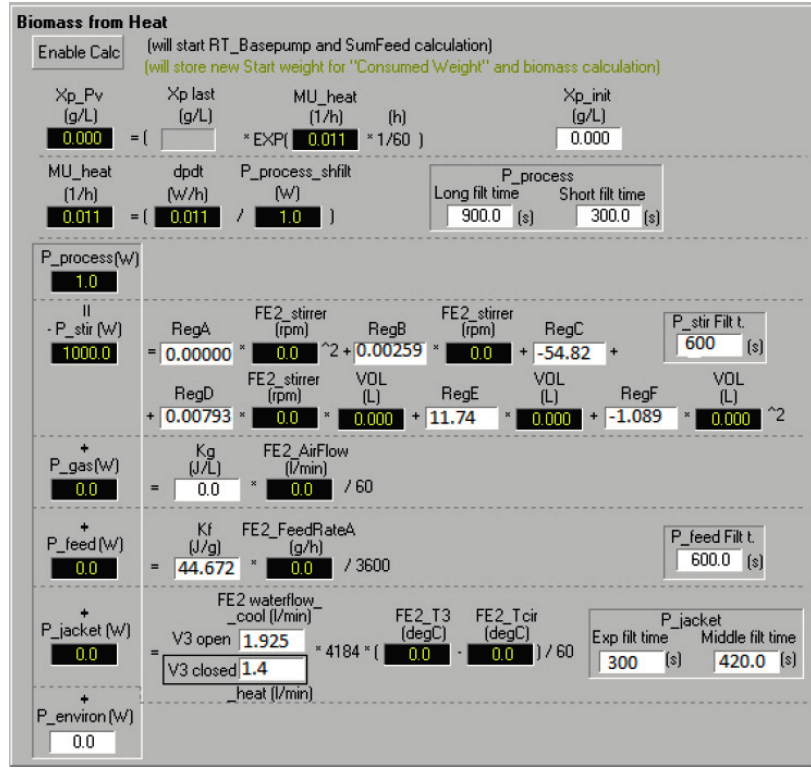
Figure 4. ( a ) The user interface of the soft sensor model ( P = q heat W = J·s − 1 ); ( b ) A sub-interface of the soft sensor model for setting the feed profile and parameters of the PID controller used for control µ metabol of the bioreactor